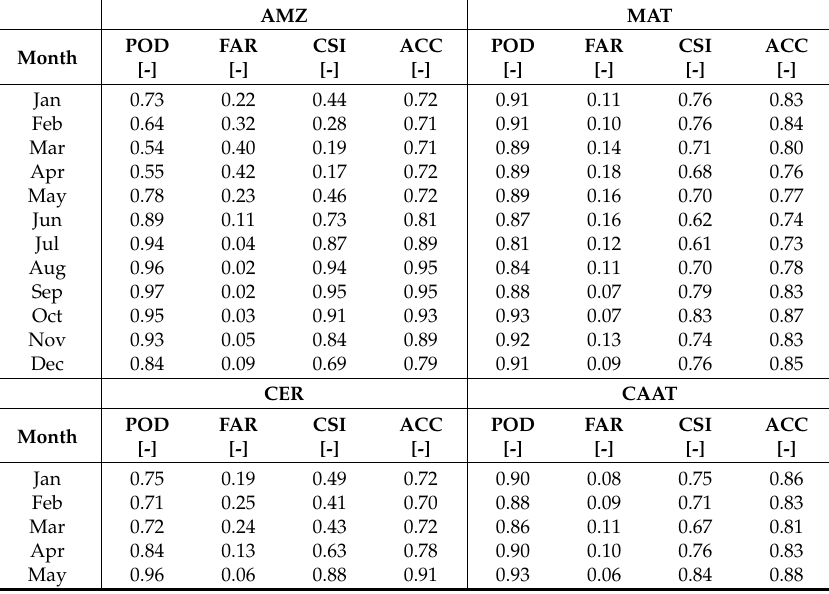
Table 8. As per Table 7, but for the CHIRPS rainfall product.